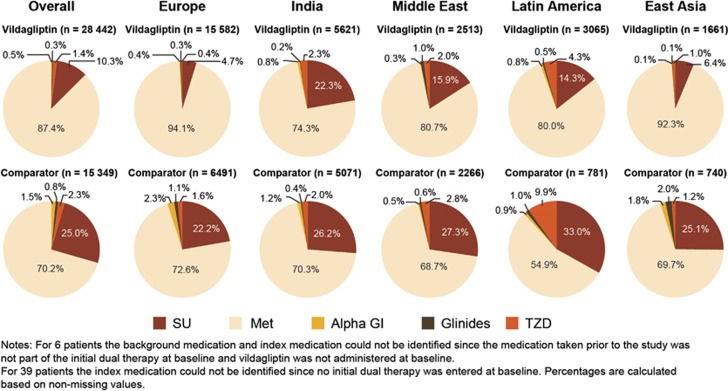
Background OAD therapy across five regions at study entry by cohort (ITT population). Alpha GI, alpha-glucosidase inhibitors; ITT, intention-to-treat; Met, metformin; OAD, oral antidiabetes drugs; TZD, thiazolidinediones.